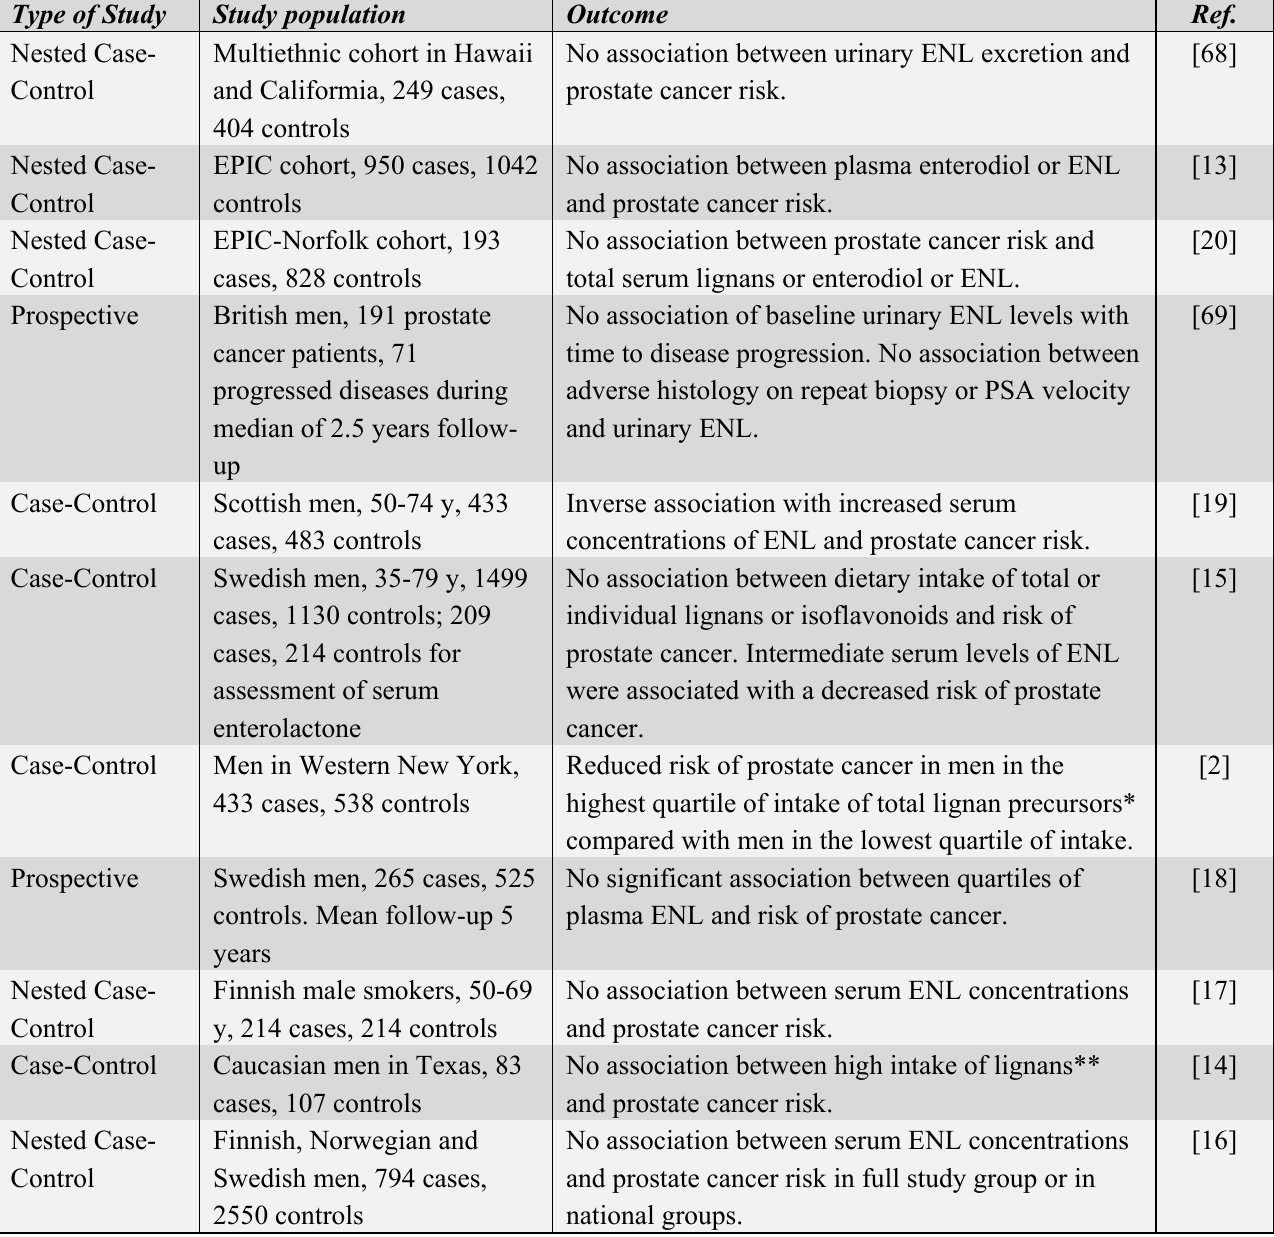
Table 1. Epidemiological studies on the association between lignans and prostate cancer risk.